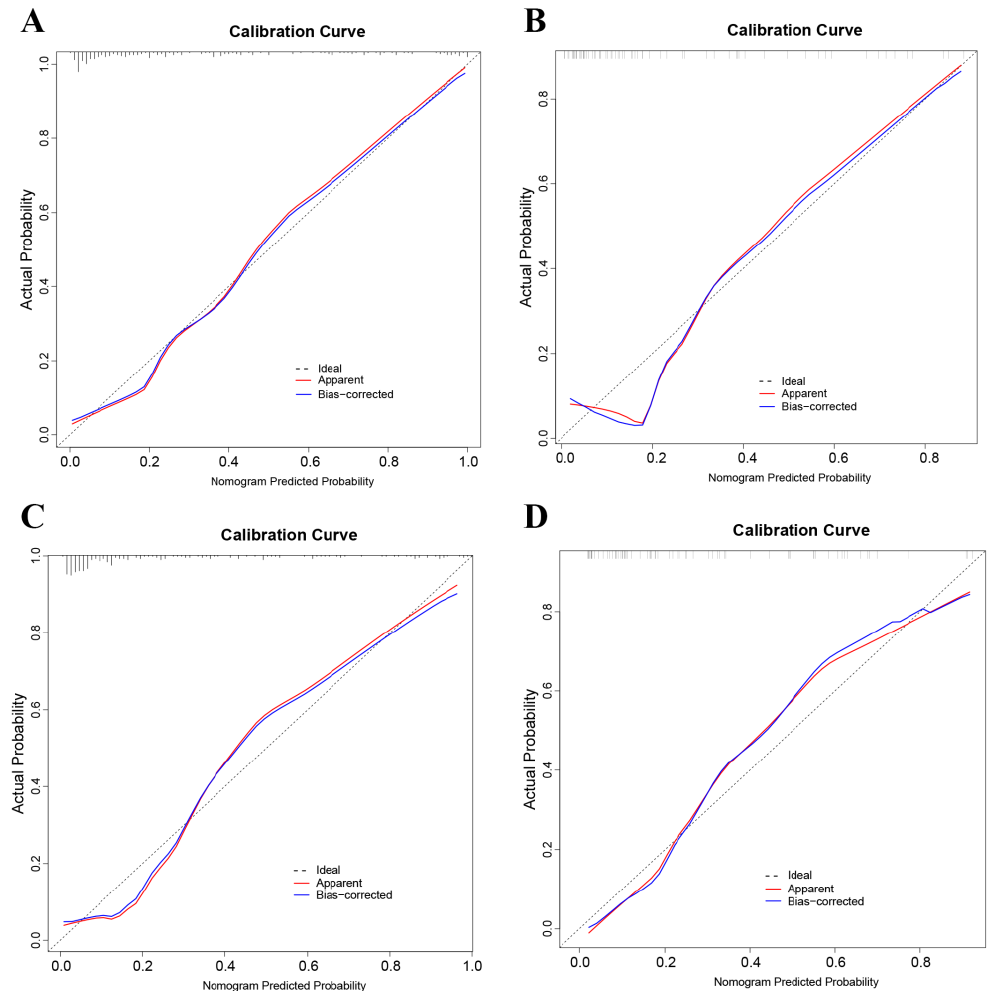
Figure 3. Prediction nomogram calibration curves for PCa in the training cohort ( A ) and validation cohort ( B ). The calibration curves for the CSPCa prediction nomogram in the training cohort ( C ) and validation cohort ( D ). On the x-axis, the nomogram-predicted probability is displayed, while on the y-axis, the actual probability of PCa or CSPCa is displayed. An ideal curve with a black point is represented by the black pointed line, an apparent curve with a red solid line represents the apparent curve that has not been corrected, and a bias-correction curve derived from bootstrapping (B = 1000 repetitions) is represented by the blue solid line. PCa: prostate cancer; CSPCa: clinically significant prostate cancer, defined as Gleason Grade ≥ 2.